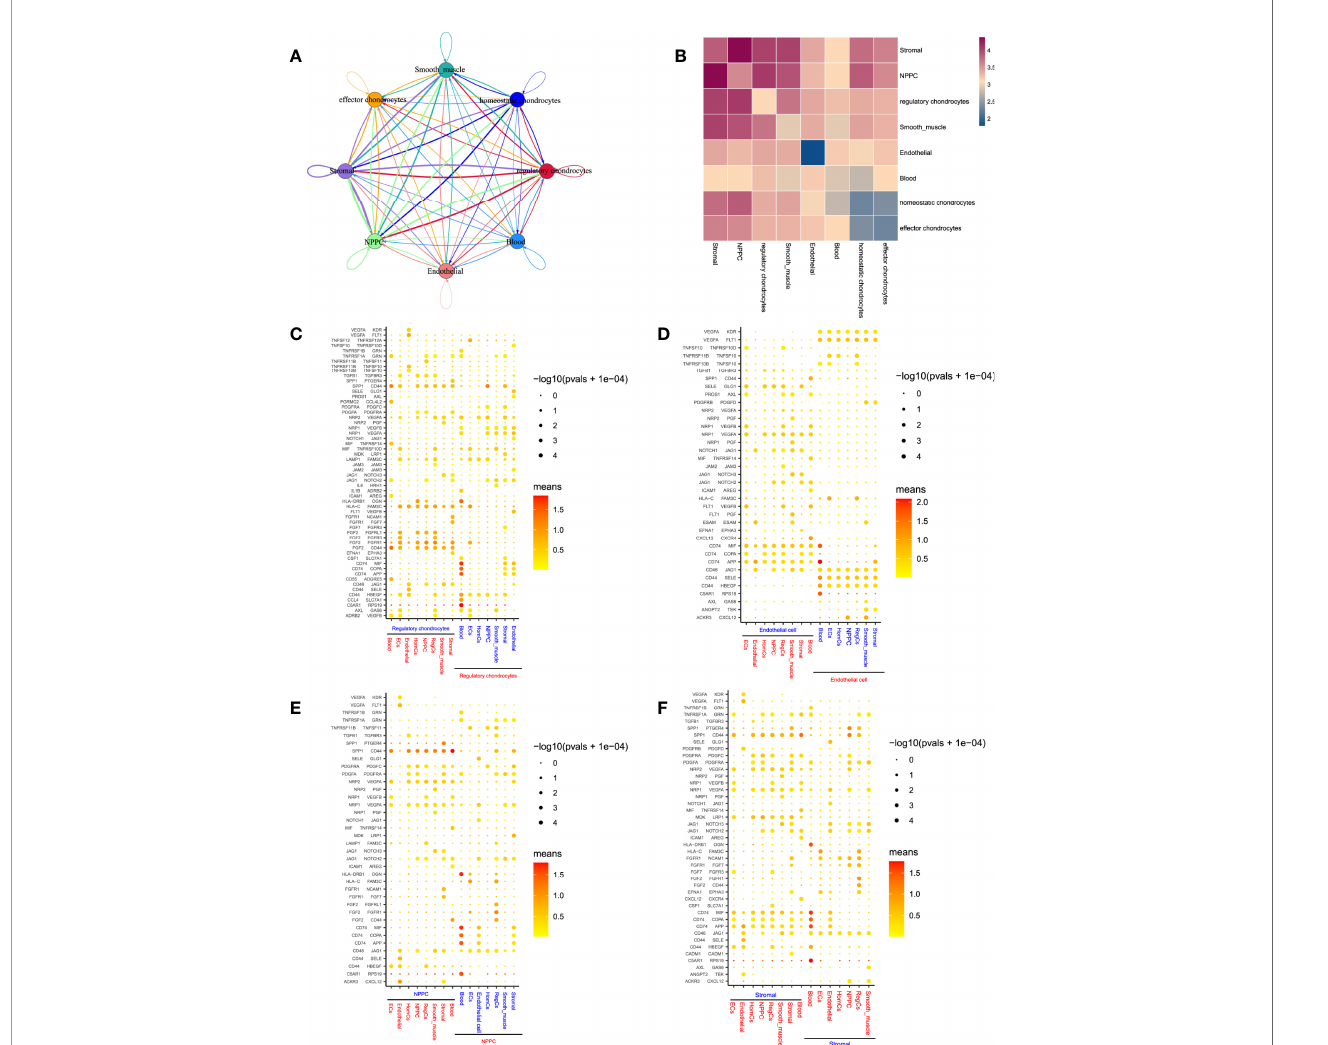
FIGURE 9 | Predicted cell populations regulatory network in CEP. (A) , Overall view of the cellular inter-regulatory network. Dot size indicated the relative quantity of each cluster; line thickness represented the relative quantity of signi fi cant ligand-receptor pairs. (B) , Correlation heatmap revealed the number of potential ligand- receptor pairs between cell groups. (C – F) , Bubble plots showing each statistically signi fi cant ligand-receptor pair in regulatory chondrocytes, endothelial cells, NPMSC and stromal cells,